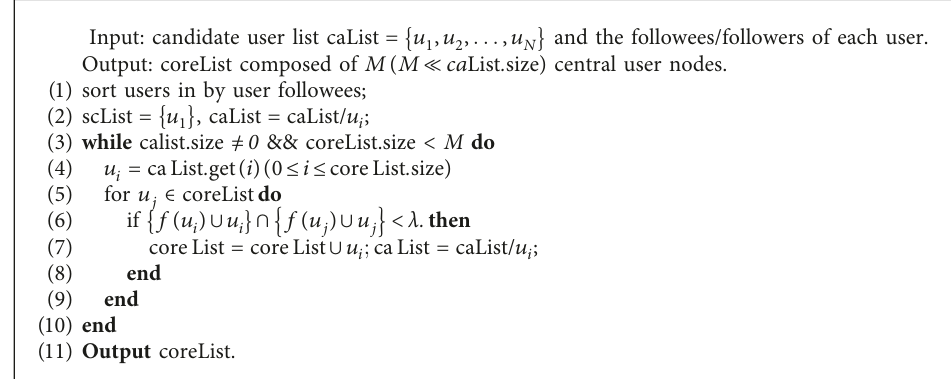
, u , ... , u 􏼈 􏼉 and the followees/followers of each user. N 1 2